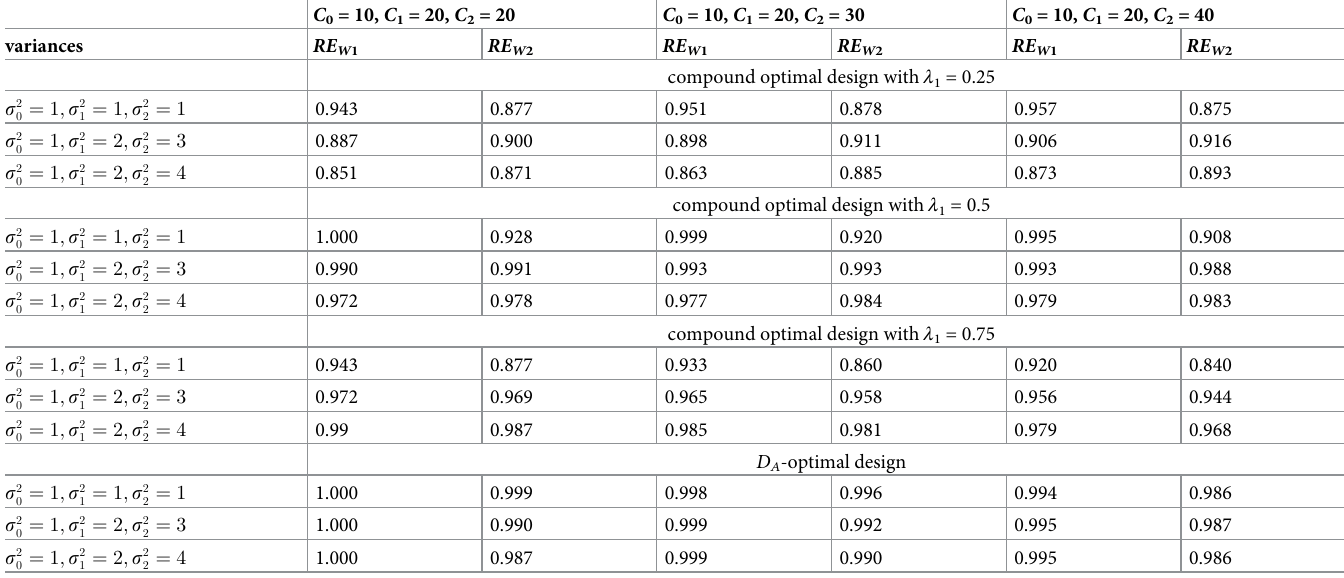
Table 3. Efficiency of uniform allocation relative to optimal allocation.